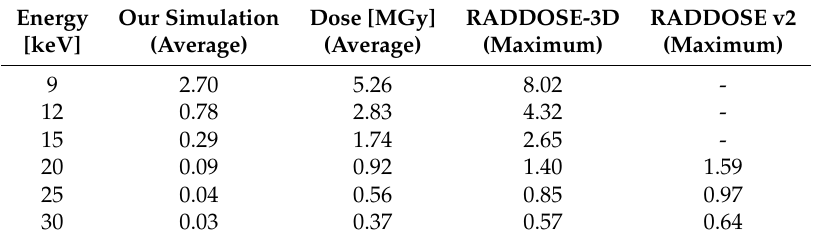
Global dose, as calculated by our simulations, RADDOSE-3D [9], and (for beam energies (cid:62) 20keV) RADDOSE v2, for a 1µm crystal in a 1µm (FWHM) beam with flux of 1 × 10 10 photonss −1 and energy ranging from 9keV to 30keV. The total dose calculated by RADDOSE v2 for Gaussian beams is the maximum dose, not the average, hence, we compared it to the maximum dose reported by